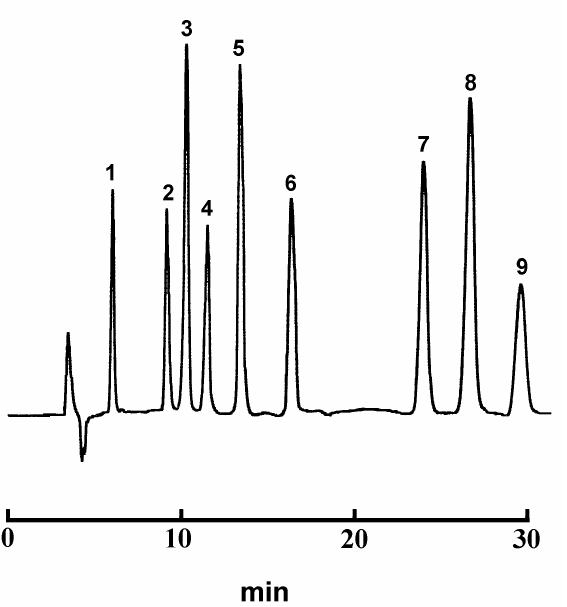
Fig. 3 Optimized separation of nine compounds. Mobile phase: 7.5 mmol/L